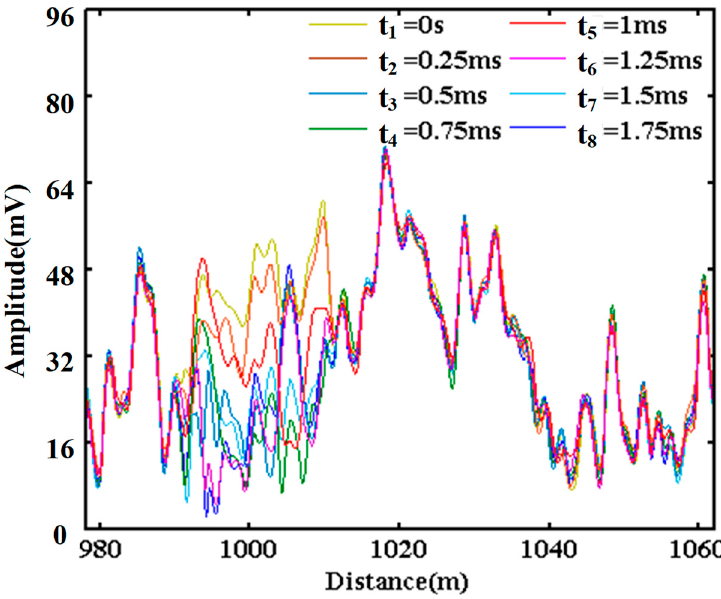
Figure 8. Superimposed amplitude curves of COTDR at different times.